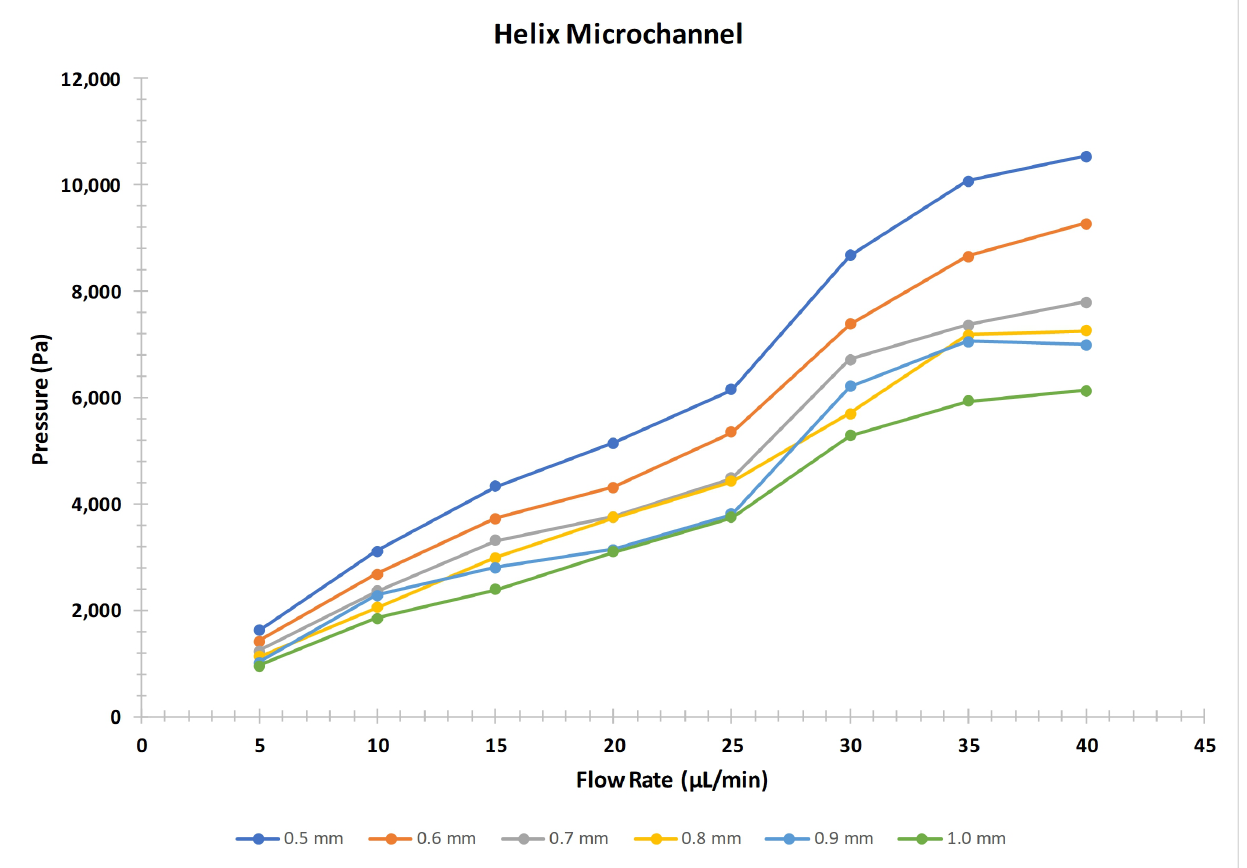
Figure 9. Helical microchannel pressure profile with respect to flow